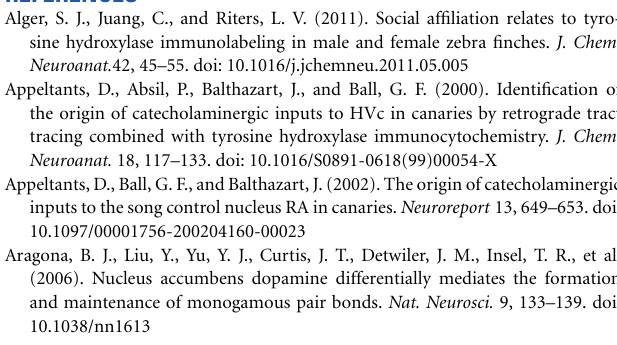
Supplementary Figure 1 | Lack of relationship between pair valence and c-Fos expression in additional dopaminergic areas. In A11 of SCI, A14, A15, and A10 of caudal VTA (cVTA), the percentage of dopaminergic neurons expressing c-Fos was not significantly related to valence of females (filled symbols) or males (empty